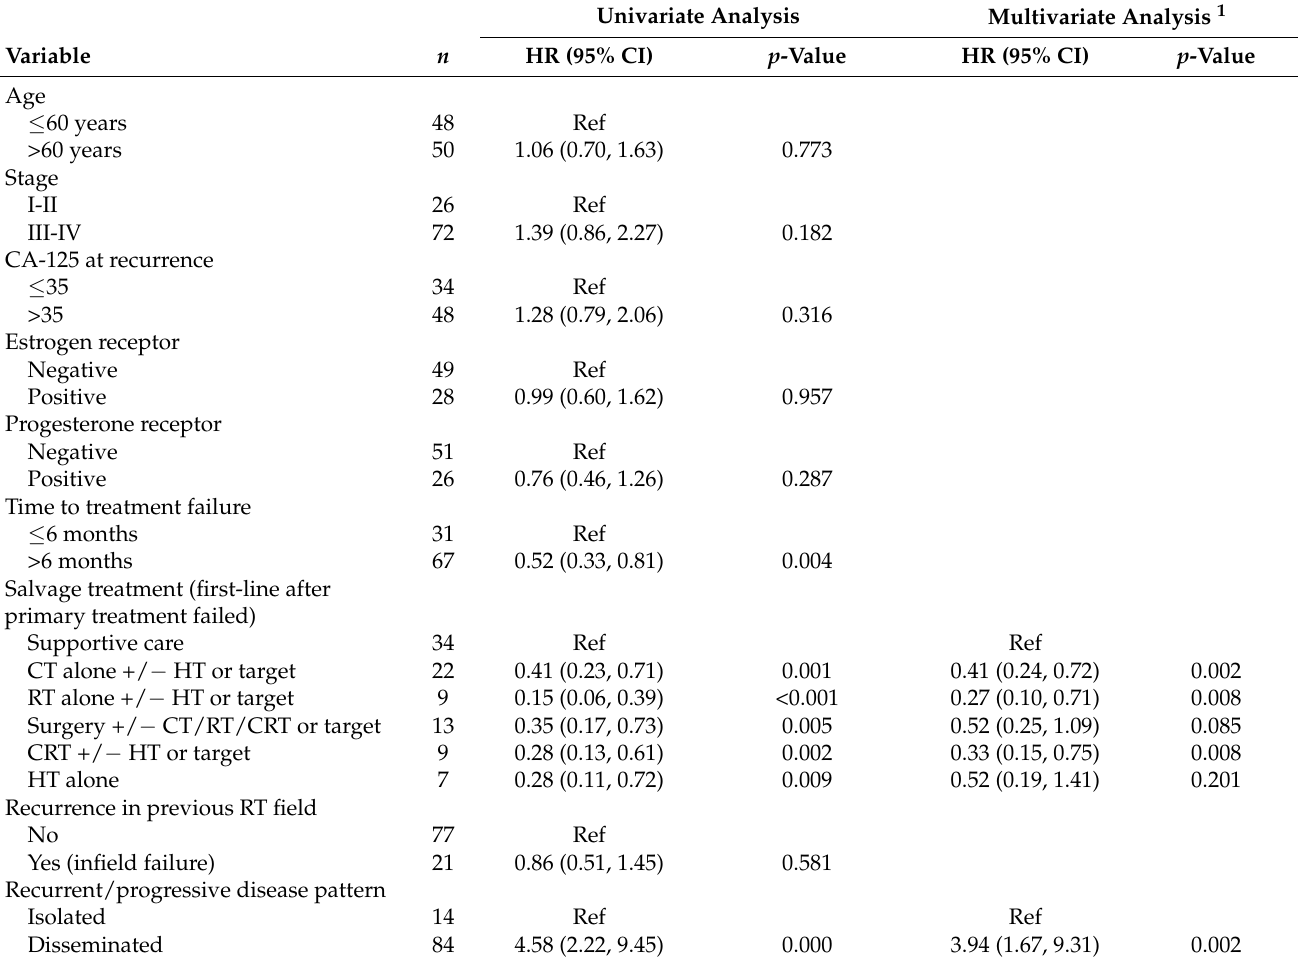
Table 4. Univariable and multivariate analysis of survival after recurrence in recurrent/progressive uterine carcinosarcoma patients ( N =